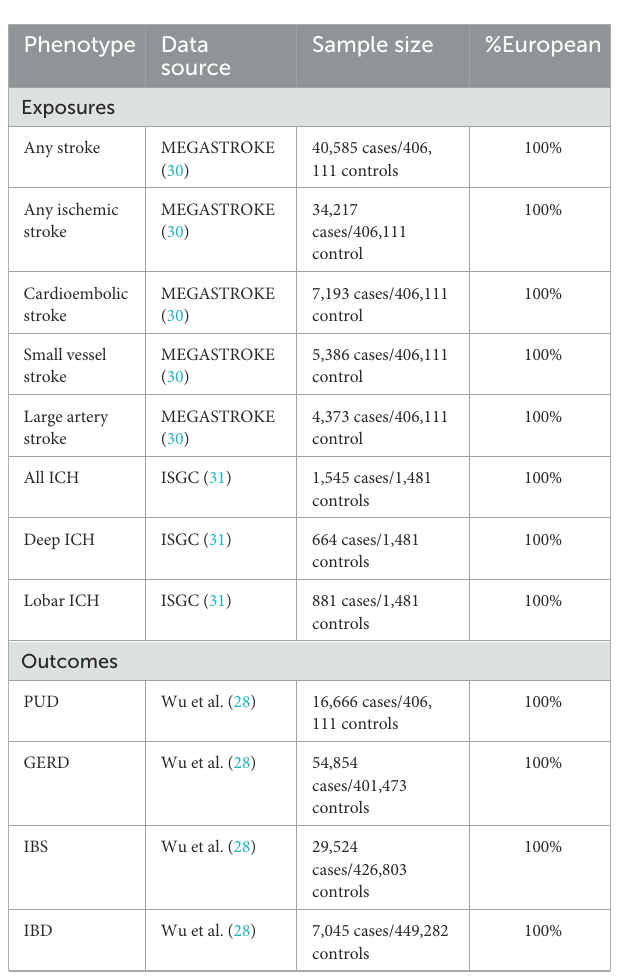
TABLE 1 Details of the GWAS included in the